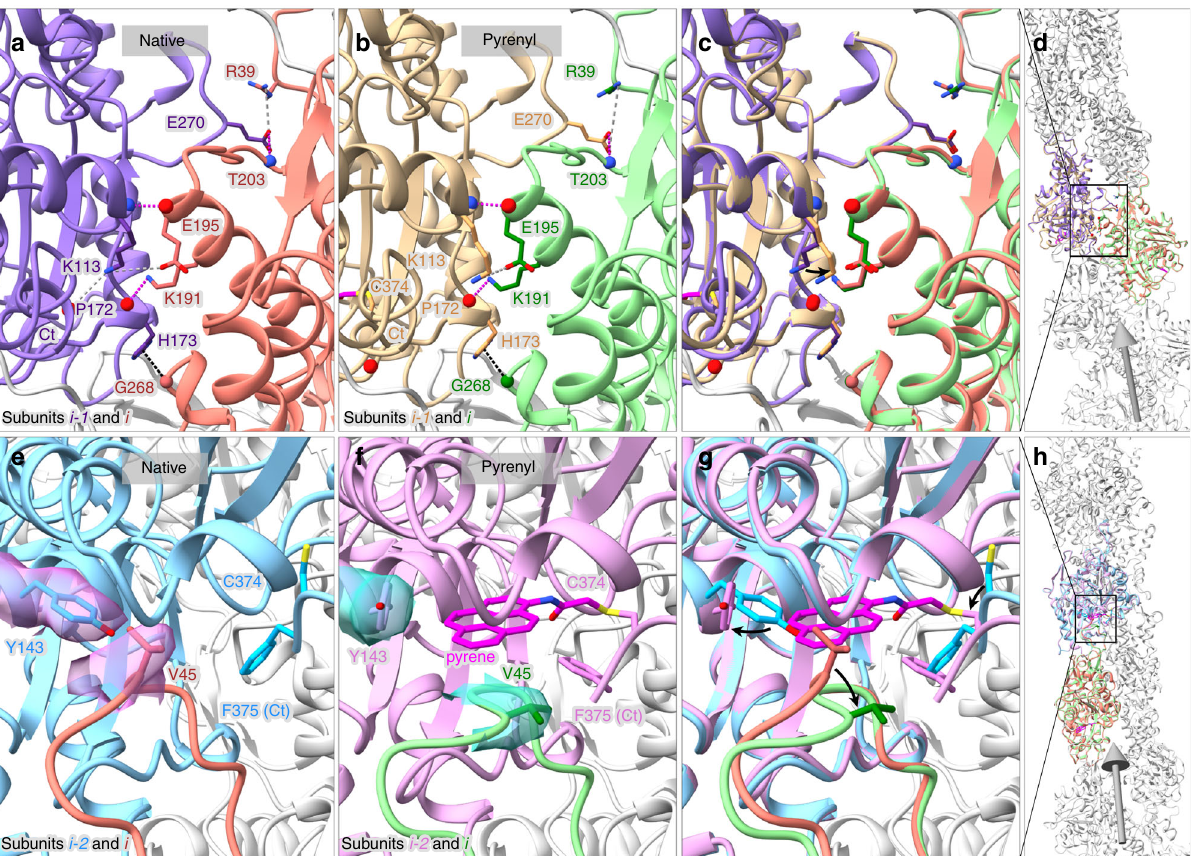
Fig. 3 In fl uence of pyrene labeling of C374 on subunit interactions in actin fi laments. Ribbon diagrams have stick fi gures of important side chains and balls for important backbone nitrogen atoms (blue), oxygen atoms (red), and C α atoms (green or salmon). Gray arrows on the right column have their arrowheads pointing along the fi lament axis toward the pointed end. Subunits in native actin fi laments are colored sky blue (subunit i-2 ), medium purple (subunit i-1 ), and salmon (subunit i ); subunits in pyrenyl-actin fi laments are colored plum (subunit i-2 ), tan (subunit i-1 ), and light green (subunit i ). Dashed lines show charge-charge interactions (gray), hydrogen bonds (magenta), and van der Waals contacts (black). a – d Most lateral interactions along the short-pitch helix are the same without and with pyrene, but in pyrenyl-actin the side chain of K113 rotates (black arrow) and loses an electrostatic interaction with its own C-terminal carboxyl group while retaining an electrostatic interaction with the side chain of E195 of the neighboring subunit. e – h Effects of pyrene labeling on interactions along the long-pitch helix. Black arrows mark how pyrene causes localized changes in the conformations of V45 in the D-loop and the side chain of Y143 in the adjacent subunit. Insertion of pyrene between two actin subunits displaces the C α atom of V45 towards the fi lament barbed end by 2.9 Å and rotation of the side chain 44.1° without disturbing other interactions between D-loop and the neighboring subunit. Pyrene twists the aromatic ring of Y143 about 72.3°. Structures of native actin fi laments are from our previous study 7 , and those of pyrenyl-actin fi laments are from this